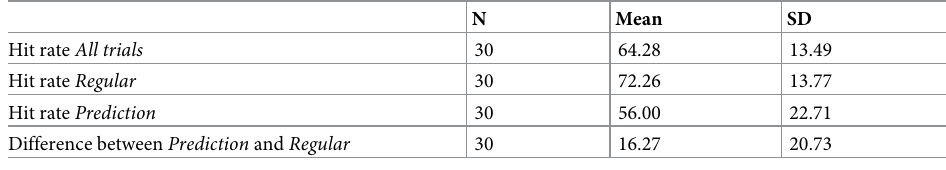
Table 3. Descriptive data of hit rates in the two experimental conditions and both conditions together (All trials).